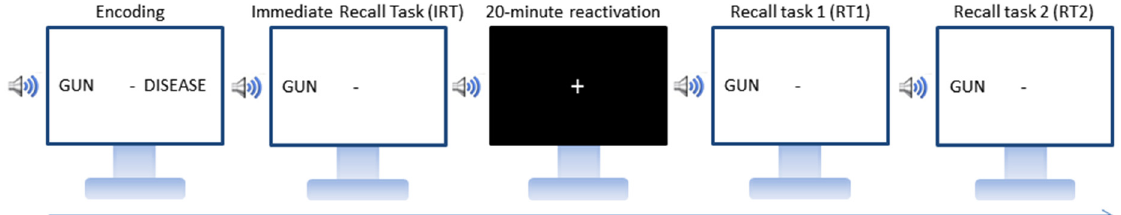
Figure 1. Experimental design. Participants learned word pairs associated with emotionally compatible sounds until reaching 75% correct recall in the immediate cued recall task (IRT). During the 20 min reactivation period in a wakeful resting state, the sounds associated with half of the neutral and negative word pairs were replayed three times, each alone (TMR-only) or concurrently with excitatory tDCS on the left (TMR-anodal left tDCS) or right (TMR-anodal right tDCS) hemisphere or in a sham tDCS condition (TMR-sham). Memory for all learned word pairs was then tested in a cued recall task immediately after (RT1) and one week later (RT2).